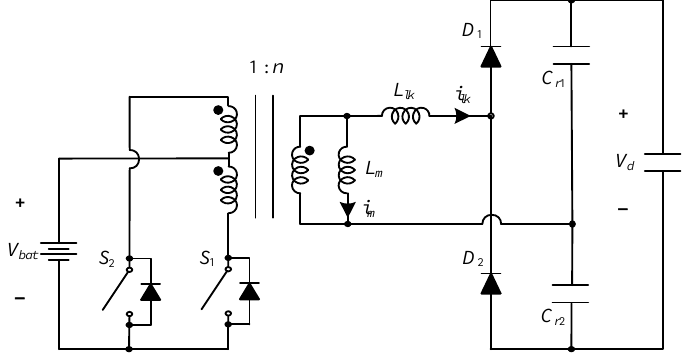
Figure 2. Proposed step-up DC–DC converter.